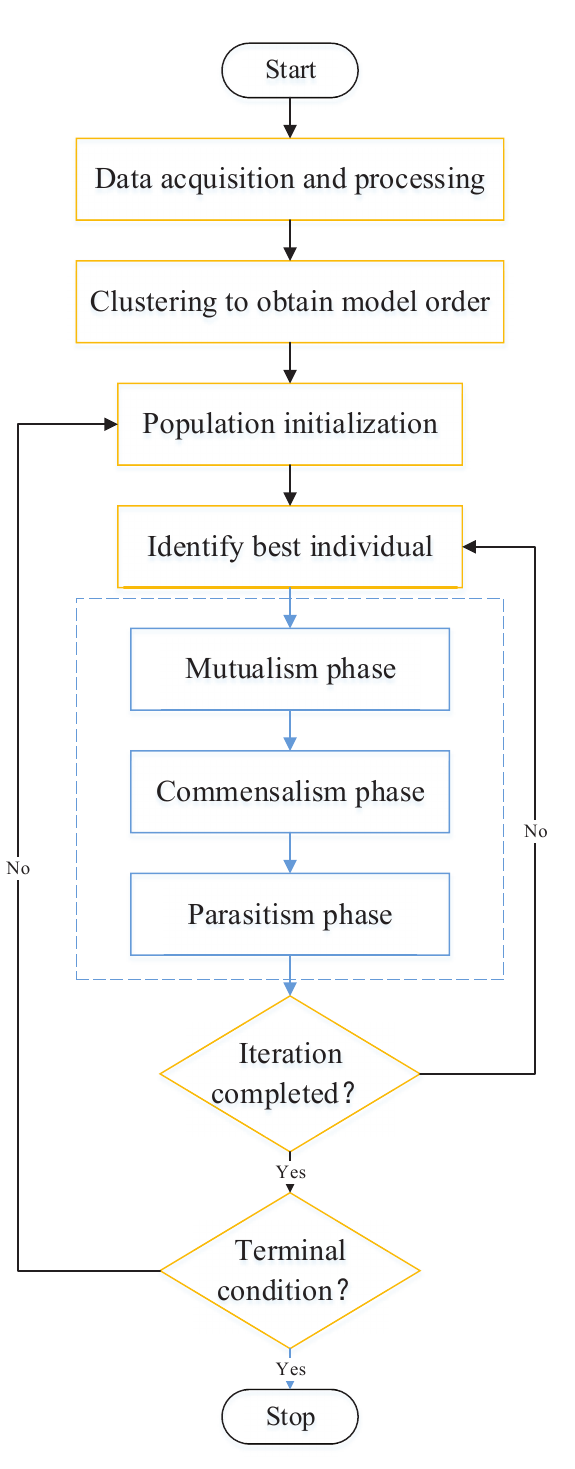
Figure 5. The identification flowchart of K-means–SOS–Fourier method for temperature